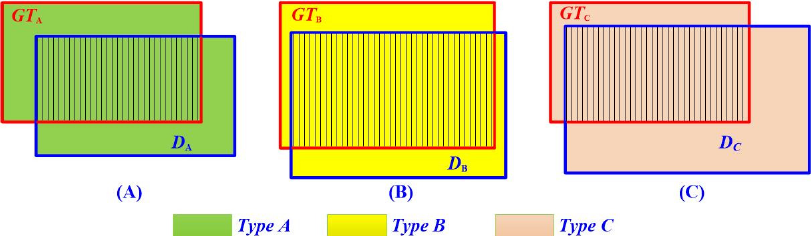
Figure 7. The schematic diagram of computing overall accuracy. ( A )-( C ) are the overlapping areas of detected results and ground truth for type A, type B and type C.